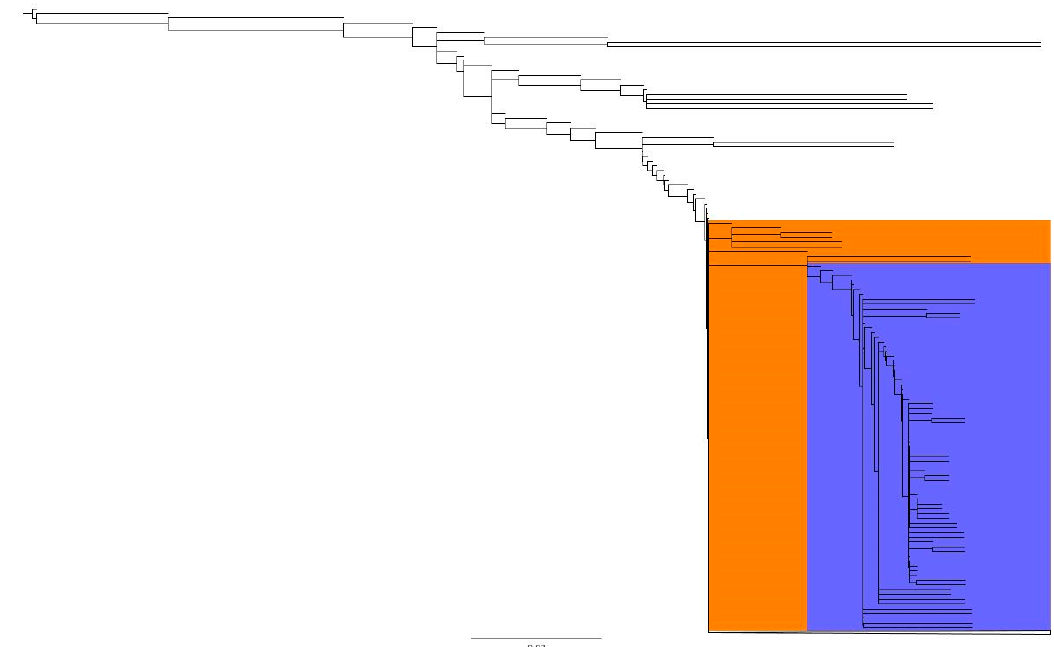
Figure 4. Root of the dendrogram of pESI plasmids based on the presence and absence of genes detected in two or more isolates. Orange cluster only contained plasmids from Peru and one from Ecuador. Purple cluster is a sub-cluster of the orange cluster containing isolates with a specific group of genes. Scale represents Jaccard distance.